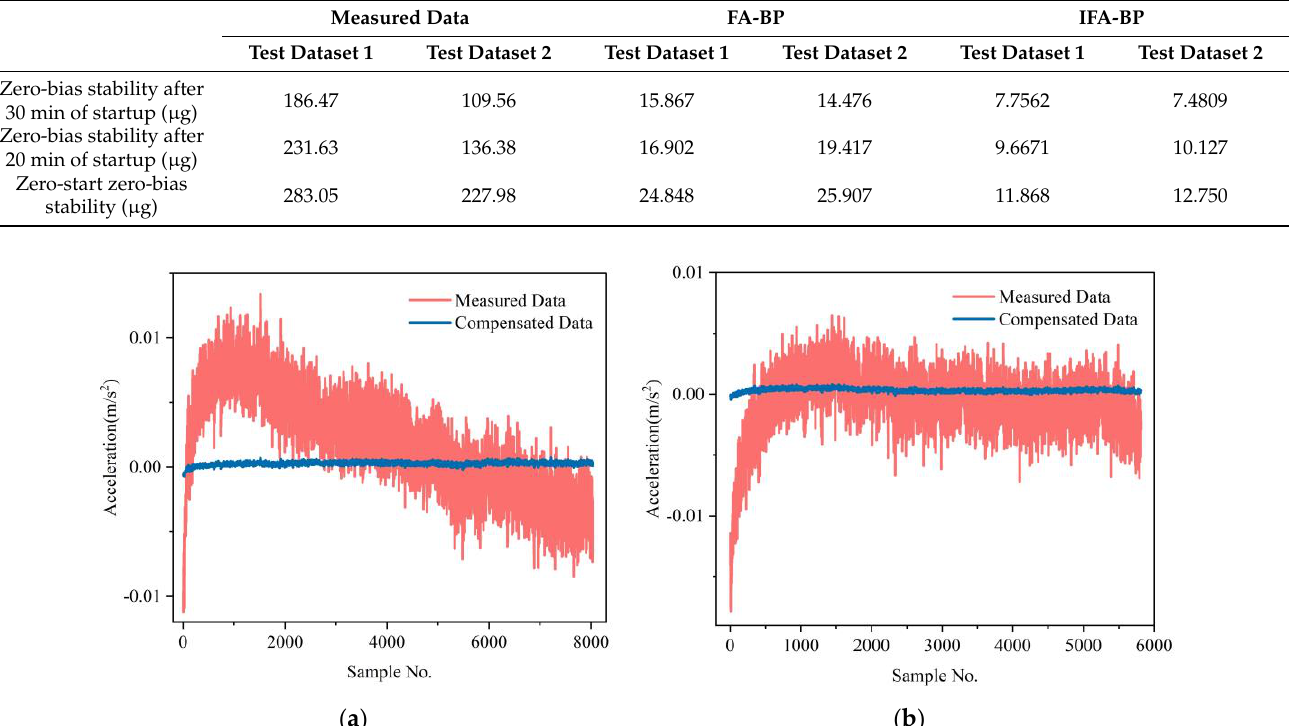
Figure 7. The IFA-BP compensation results of the accelerometer at room temperature: ( a ) test dataset 1; ( b ) test dataset 2.